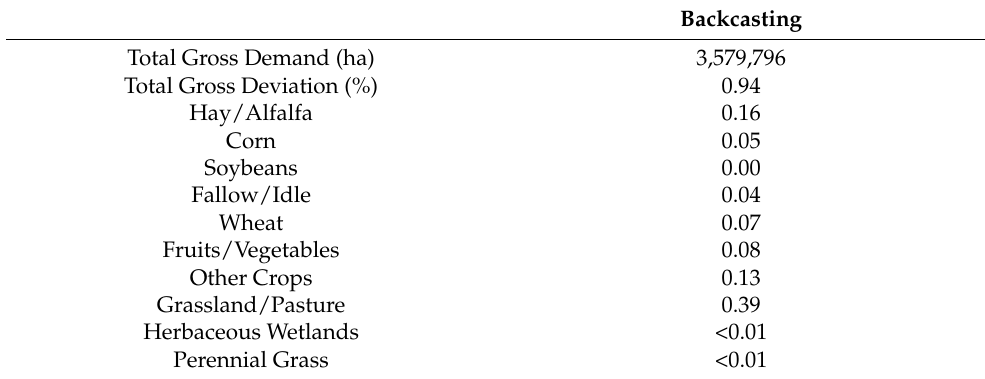
Table 3. Gross prescribed change (both positive and negative) and absolute deviation from prescribed change aggregated over all backcast years, separated into categories with explicitly supplied